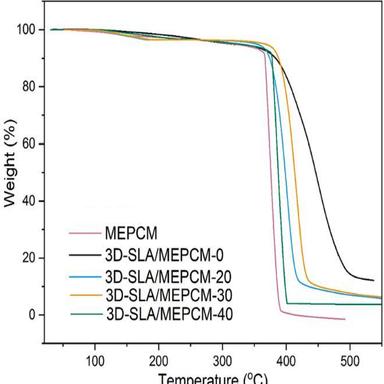
TGA thermograms of MEPCM and 3D-SLA/MEPCM composite samples.